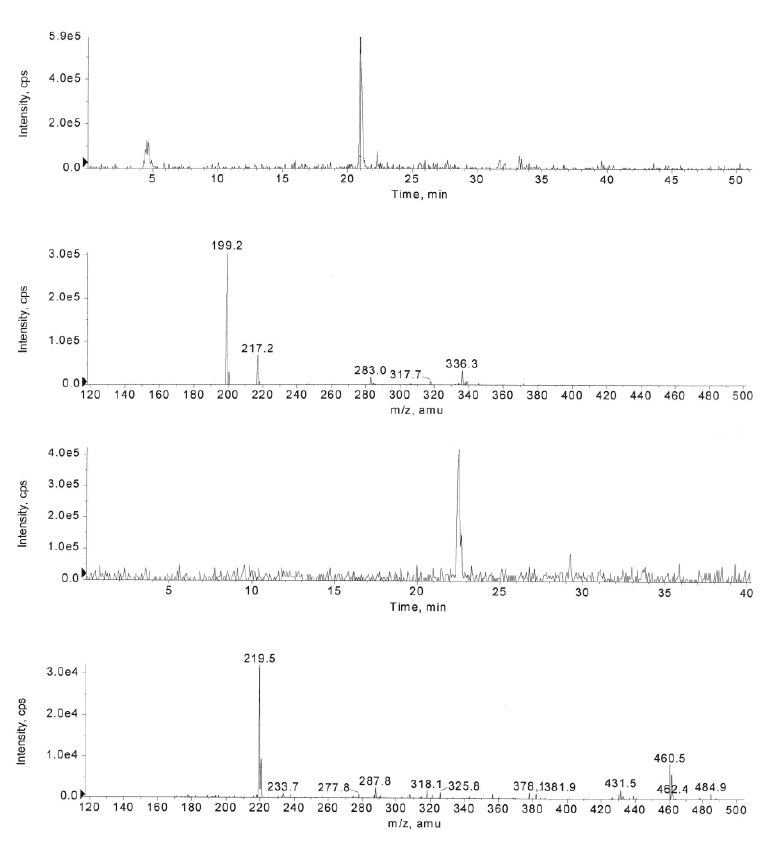
Figure 2. Inspection of mass spectra obtained from XIC m/z 217-218 (calcd. [M-H] - = 217.1) and 219-220 (calcd. [M+H] + = 219.1) for 19 during the hydrolysis of 1 (at t = 2 d) in the presence HLE at pH 7.5 and 37 °C. Chromatographic conditions: A mixture of water and MeCN containing 0.1% formic acid (linear gradient from 2% up to 60.0% MeCN in 35